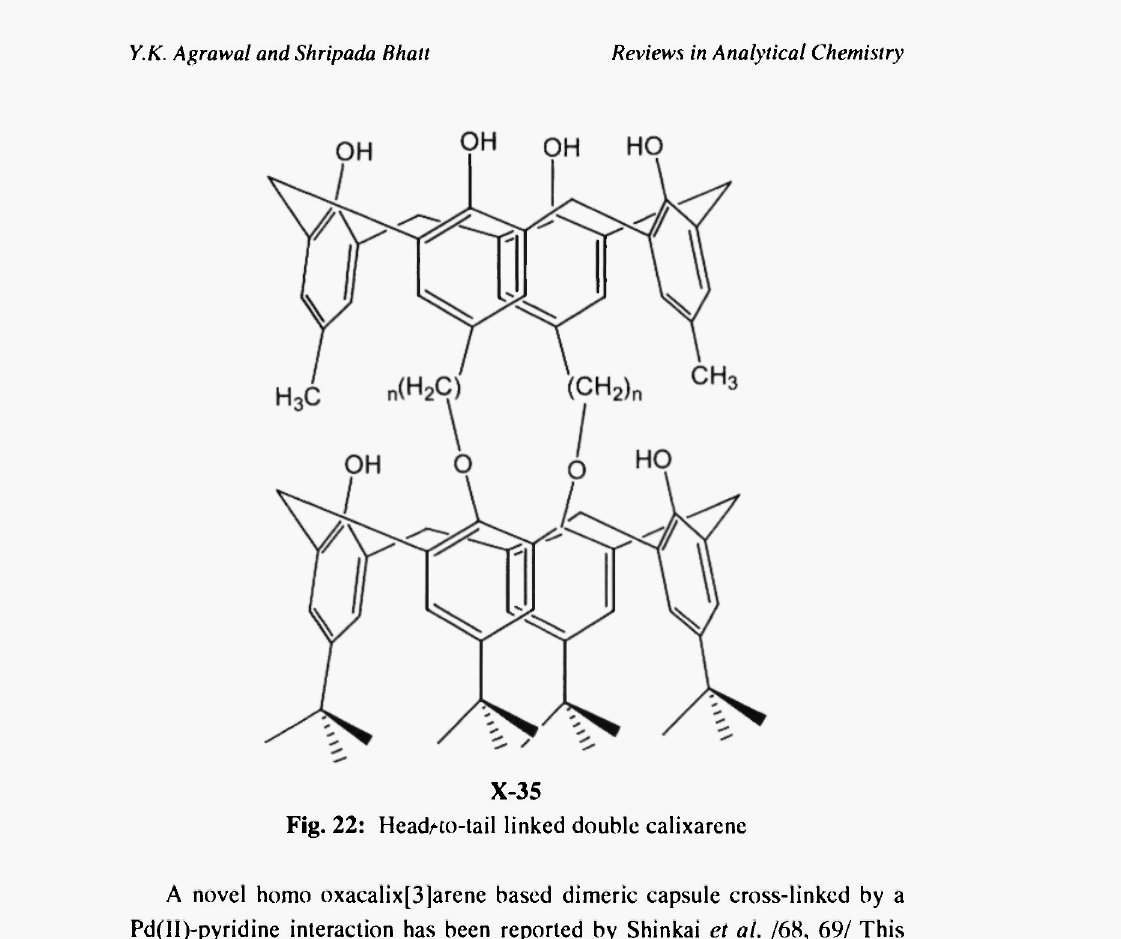
Fig. 22: HeacWo-tail linked double